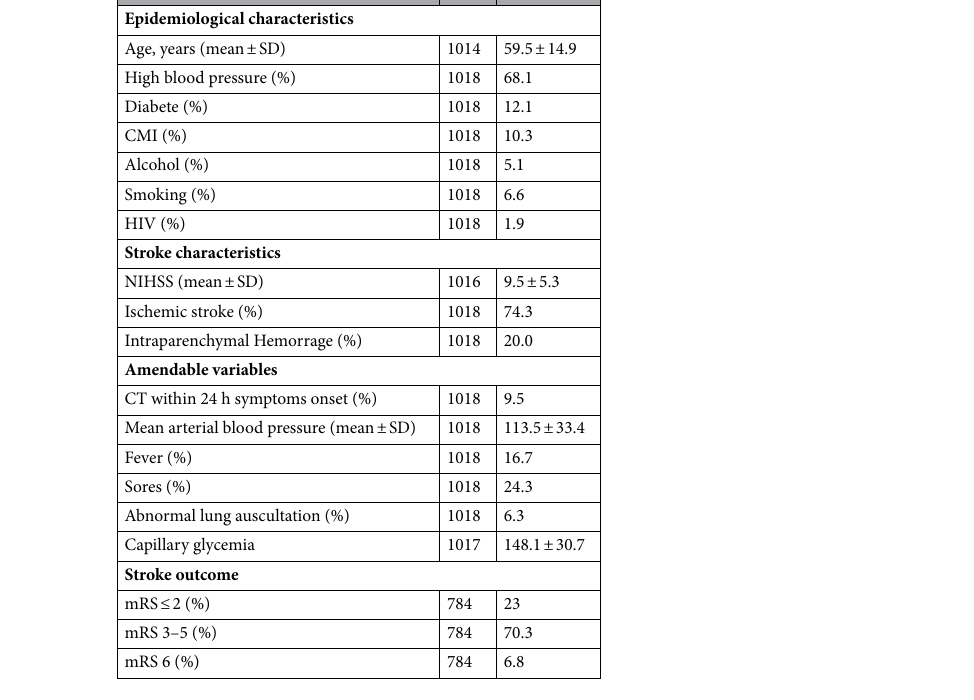
Table 1. Study patients’